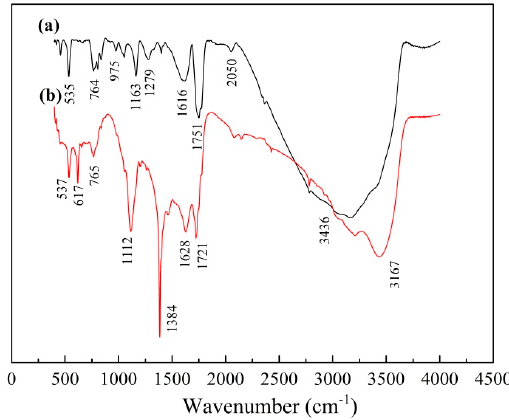
Figure 9. FT-IR spectra of (a) TSC-CC resin and (b) TSC-CC resin loaded Ag + .